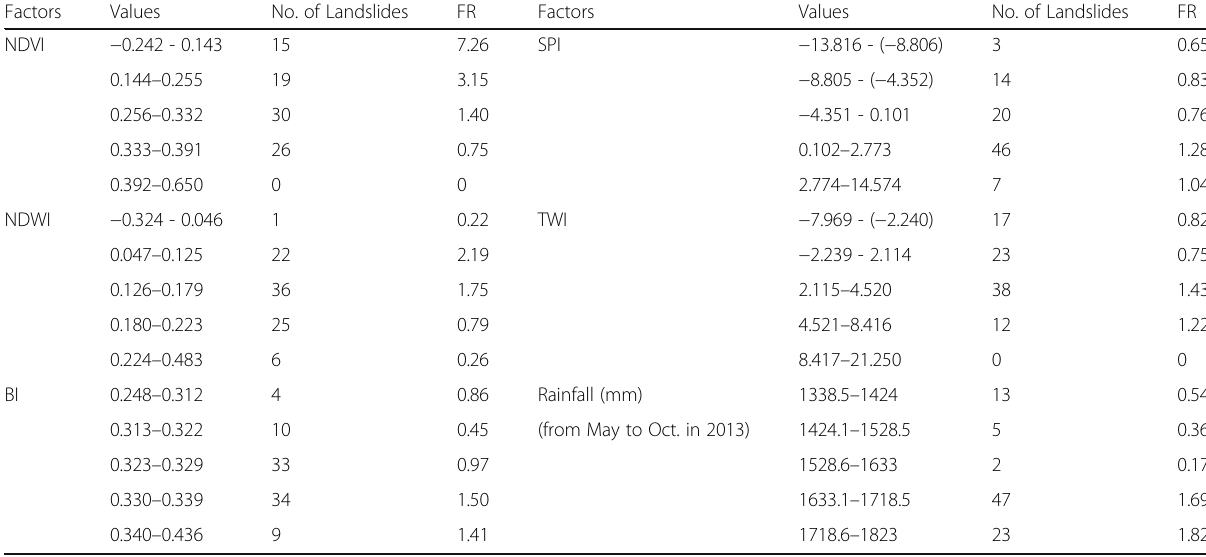
Table 2 Description and frequency ratio (FR) of remote sensing - derived index and hydrological factors in the study area Factors Values No. of